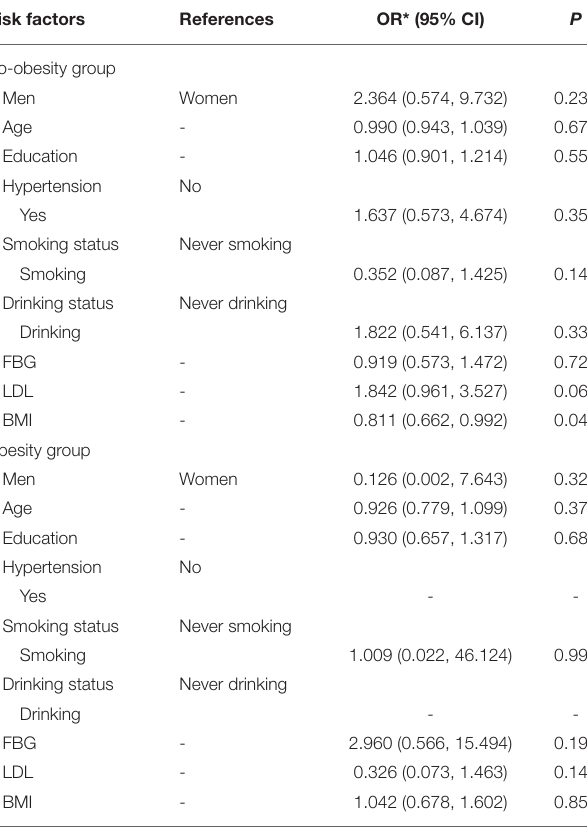
TABLE 5 | Multivariate analysis the gender differences between BMI and intracranial aneurysms among people with family history of stroke in no-obesity